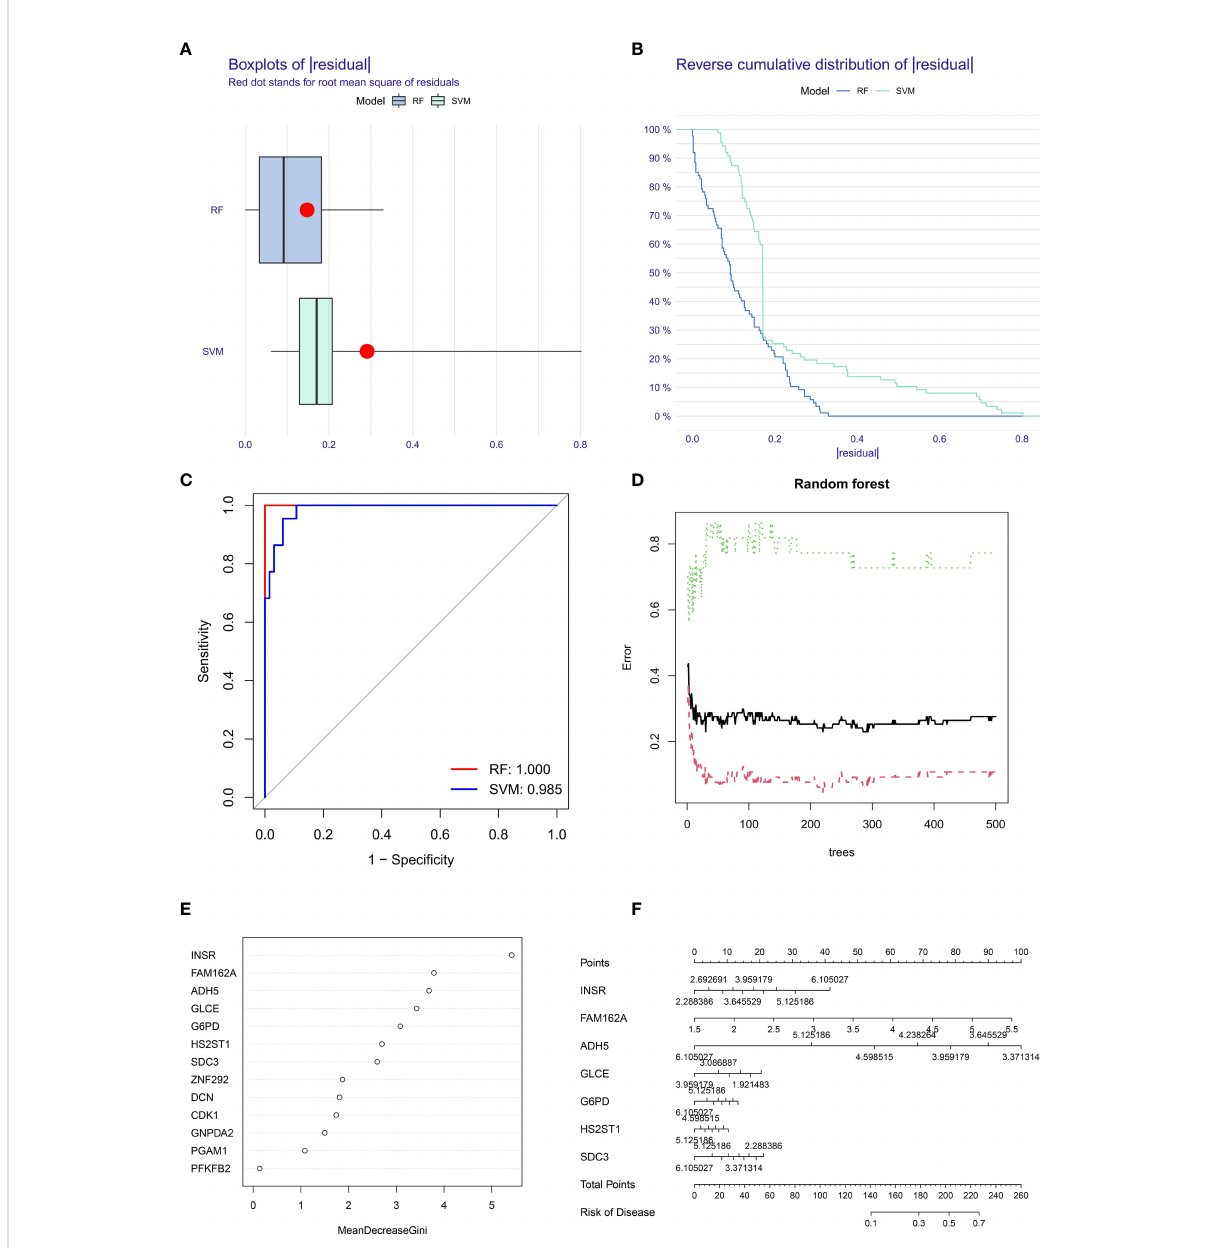
order of importance of the correlation between prognostic genes and tumor metastasis. (F) Seven prognostic genes with the highest correlation with OS metastasis constructed a metastasis related disease